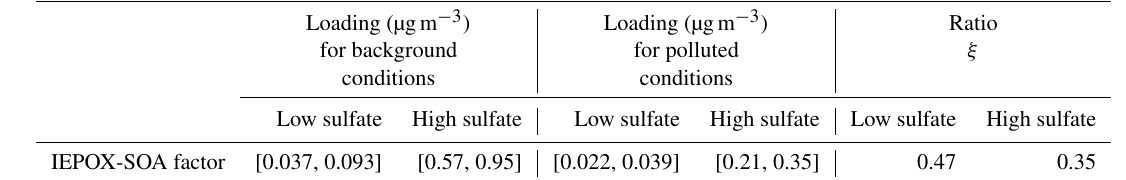
Figure 9. Modeled IEPOX-derived PM mass concentrations M pol and M bg at the T3 site under polluted compared to background conditions. The ratio ξ of concentrations (i.e., M pol /M bg ) is also plotted. Panels (a, b) correspond to Case 1 and Case 2 listed in Table 4. Gray shading indicates the range of observed values of ξ across low and high sulfate concentrations. Dashed lines indicate the intersection of modeled and observed values of ξ and the corresponding constrained values of k P or k L along the abscissa. Labels above the double-headed arrow ) . The dashed black arrow in (b) communicates that the observed values of ξ provide no in (b) correspond to characteristic times (i.e., k − 1 L constraint on the lower limit of k L . Table 3. Interquartile intervals of IEPOX-SOA factor loadings observed for background and polluted conditions. Background and polluted conditions correspond to approximately 0.5 and 2ppb of NO y , respectively. The table also lists the resulting ratio ξ of the median factor loading under polluted compared to background conditions.